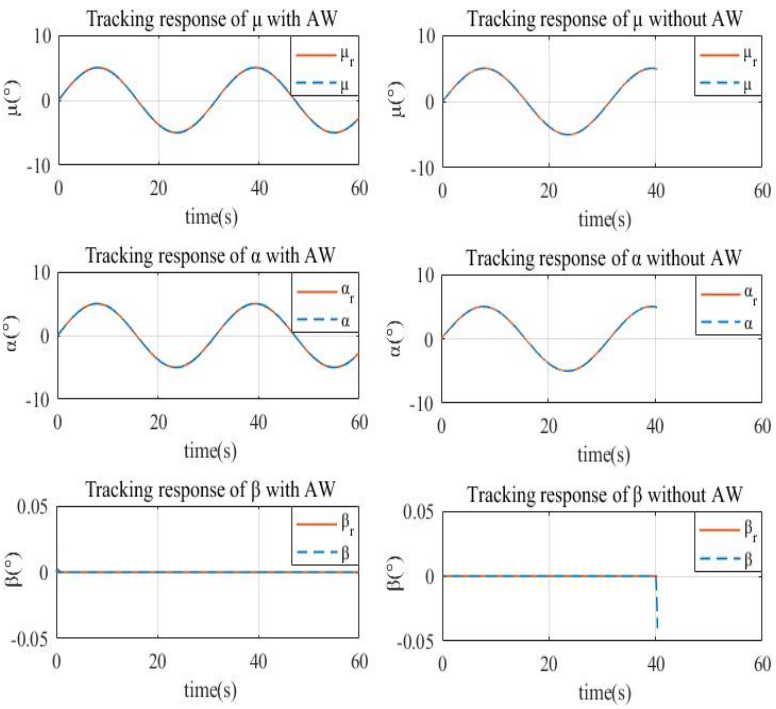
Figure 11. Tracking response µ , α and β .